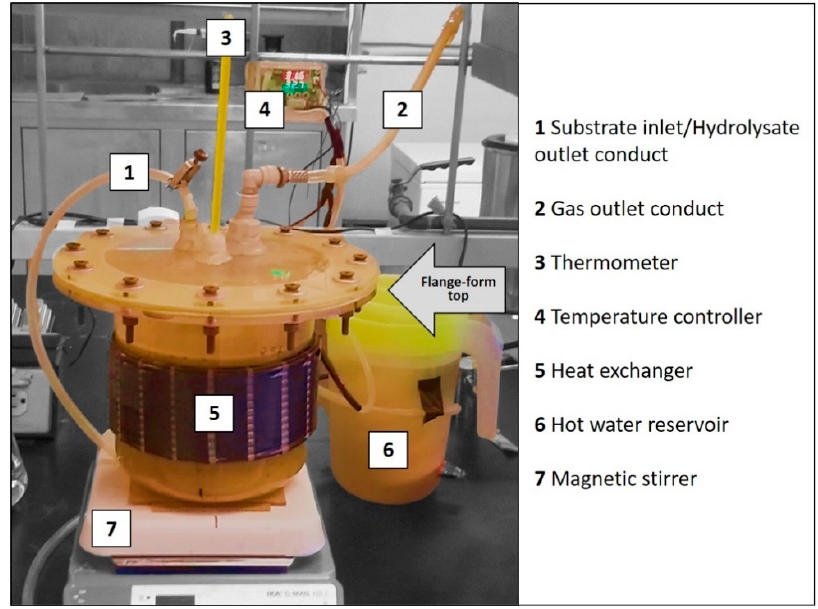
Figure 1. Anaerobic semi-continuous hydrolytic reactor configuration used during experimentation.